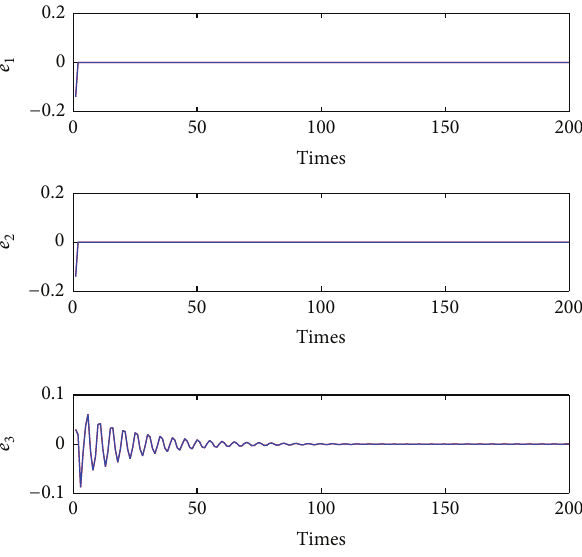
(27) and the corresponding response system (37) can realize general hybrid projective dislocated synchronization for the controller (39).